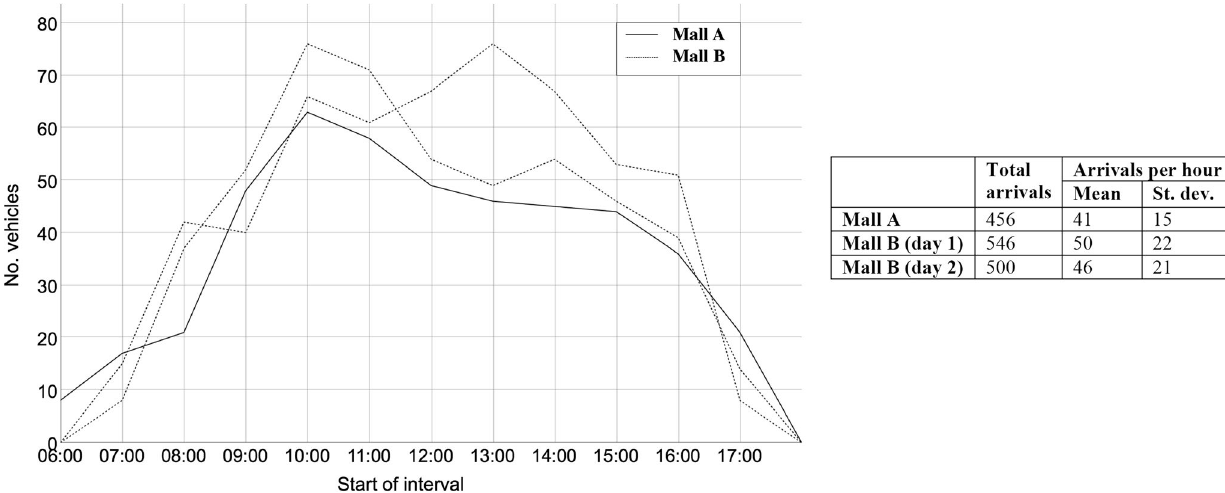
Fig. 3 Number of freight vehicle arrivals per hour, observed for one day at mall A and two days at mall